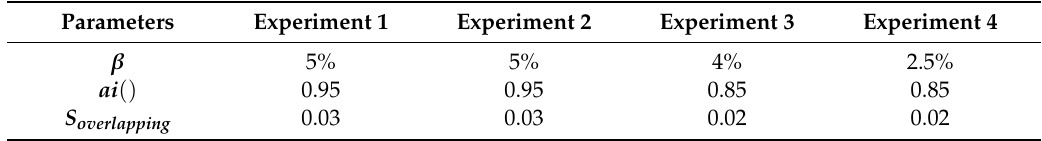
Table 1. Parameters for online map